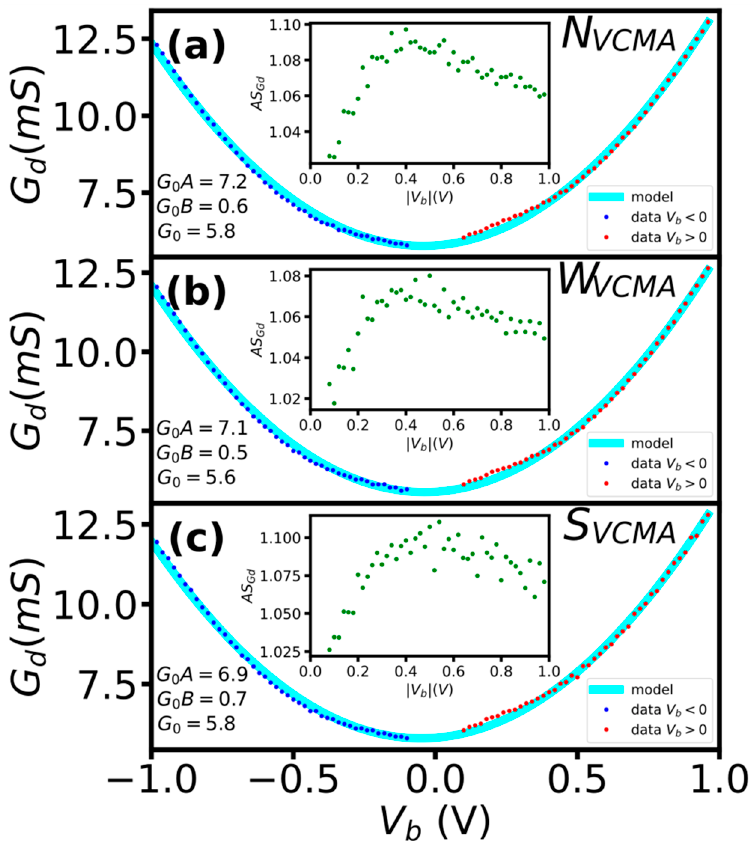
Figure 4. The influence of bias polarity on dI/dV characteristics and their symmetry (inset) of sensors without ( a ), with medium ( b ) and strong ( c ) VCMA modification. The asymmetry was computed as AS Gd = G d (+V b )/G d ( − V b ).